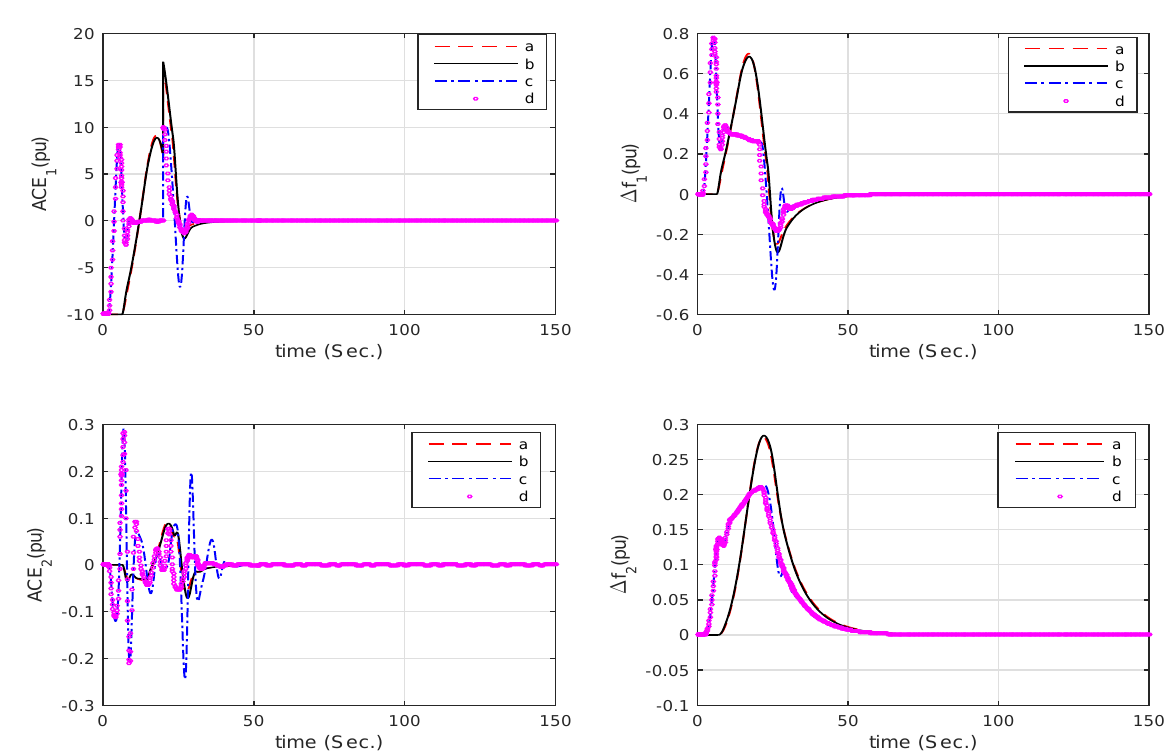
Figure 10. Frequency deviation and control error responses of two-area deregulated LFC scheme with h 1 ( t ) = 0 and different K P , K I , h 2 ( t )